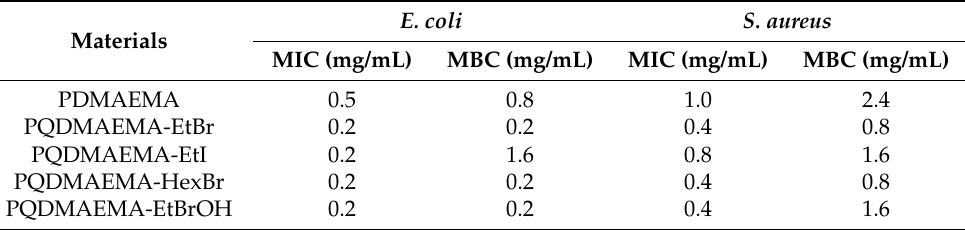
Table 1. MIC and MBC values of the cationic polymers prepared in this work and evaluated against E. coli and S. aureus